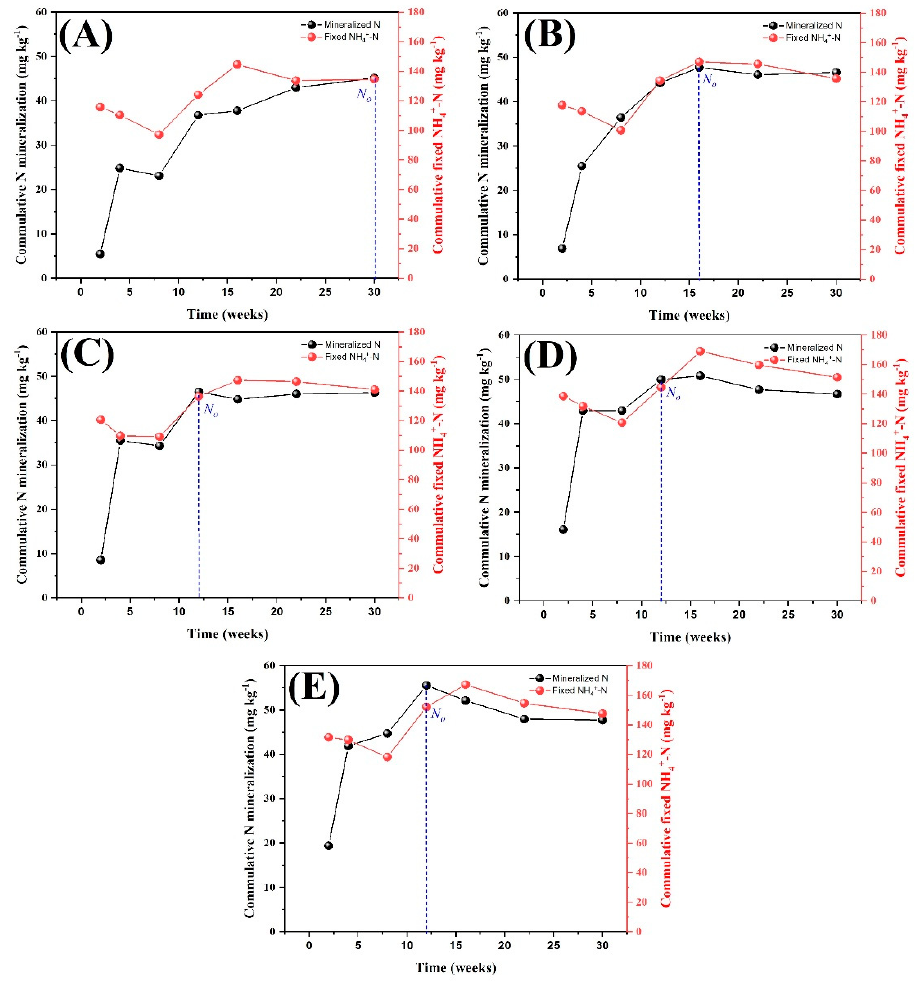
Figure 6. Temporal changes in mineralized N and fixed NH 4+ among the treatments in relation to time. N 0 showing the maximum levels of mineralized N in relation to time. CK ( A ), NP ( B ), NPK ( C ), NPKM ( D ) and 1.5NPKM ( E ).